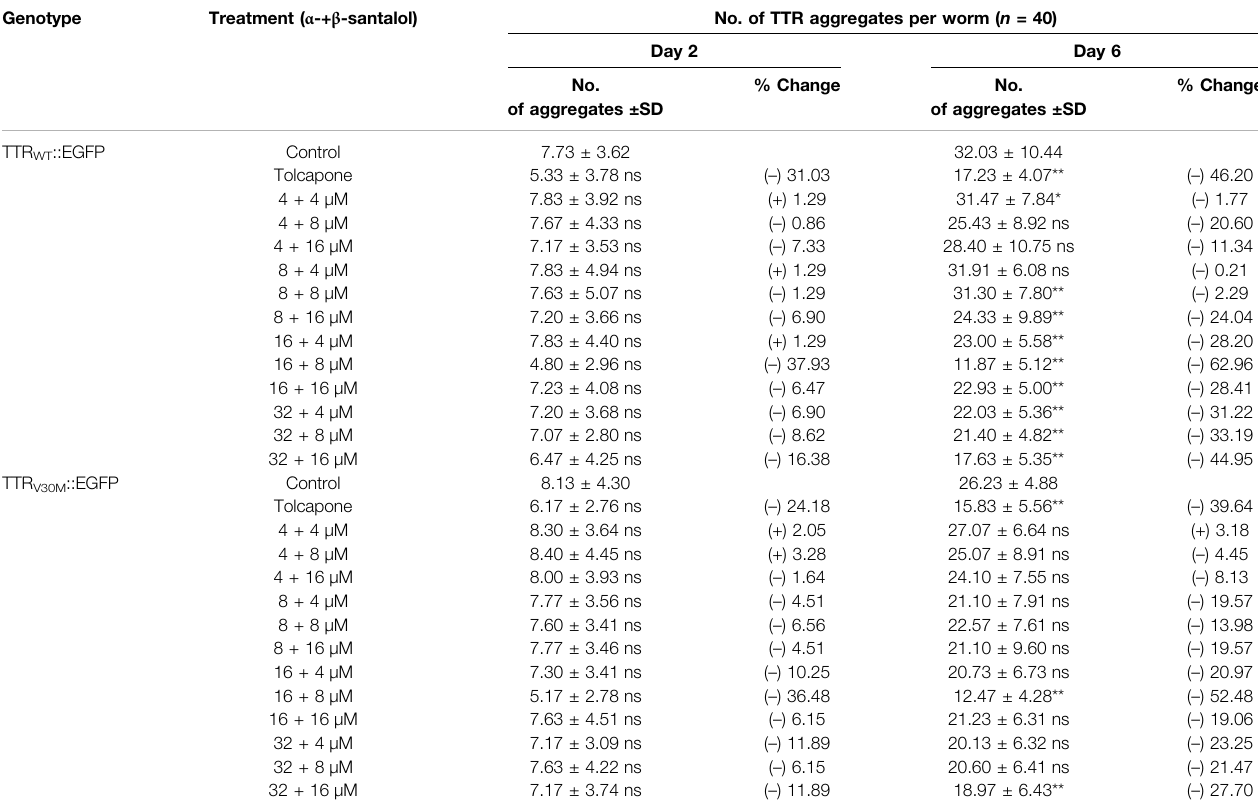
TABLE 2 | Synergistic effect of santalol isomers on the aggregation of different TTR::EGFP aggregates.